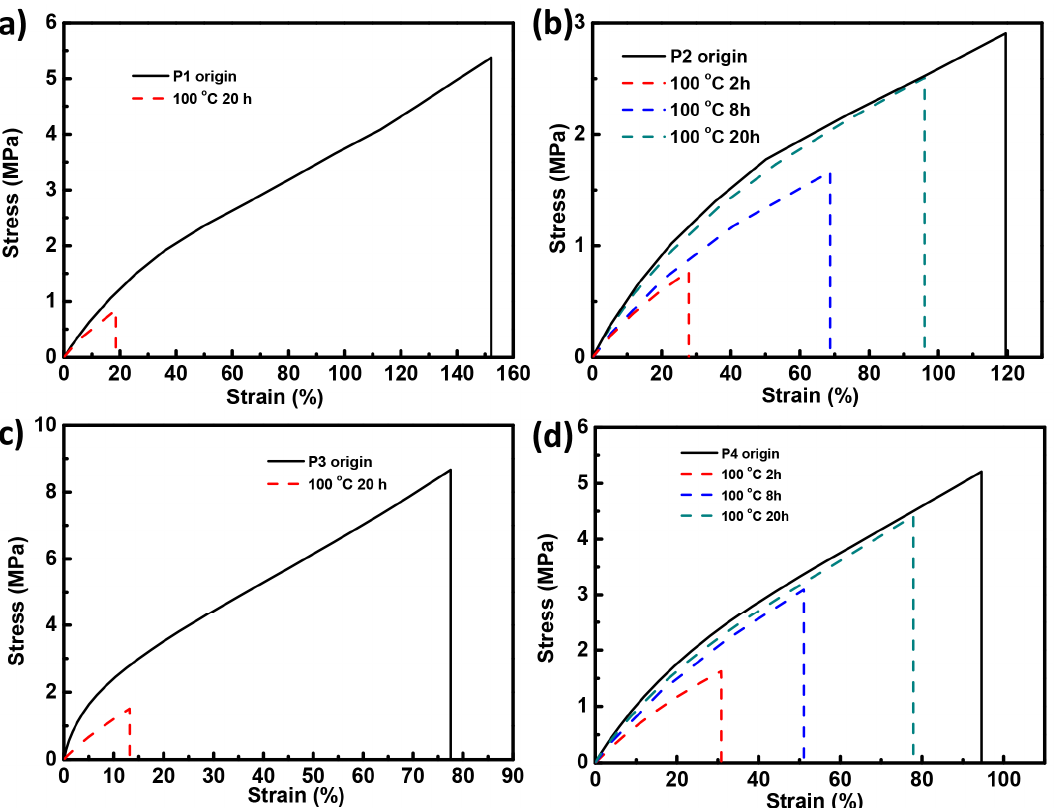
Figure 7. Stress–strain test of the self ‐ healing efficiency of the films: ( a ) film P1 and ( c ) film P3 with inefficient stress–strain recovery after 20 h of healing at 100 °C, and ( b ) film P2 and ( d ) film P4 with basic recovered stress–strain after 20 h of self ‐ healing at 100 °C. Table 4. Film self ‐ healing efficiency.